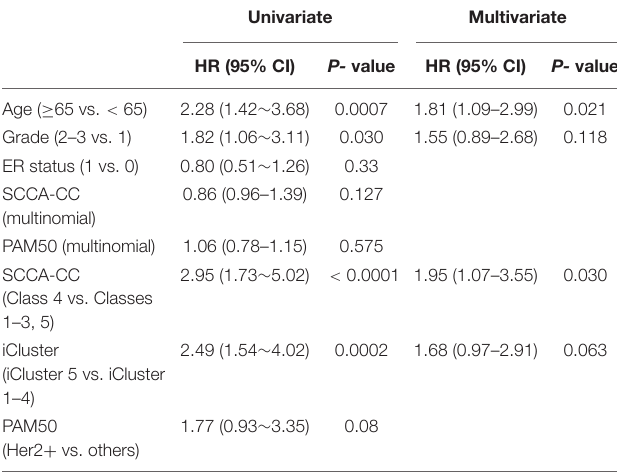
TABLE 2 | Univariate and multivariate Cox regression analyses in breast cancer using the GSE22220 series dataset. Univariate